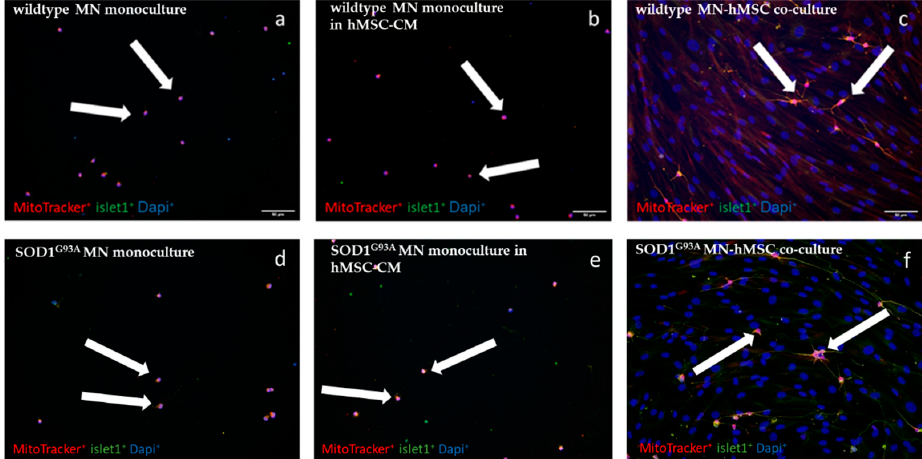
Figure 1. Increased MN number when co-cultured on hMSCs. Representative immunocytochemical stainings of MNs stained for Mitotracker (red), islet1 (green) and DAPI (blue). All images were recorded in a 20× magnification. ( a ) Wildtype MN monocultures. ( b ) Wildtype MNs cultured in hMSC-CM. ( c ) Wildtype MN-hMSC co-cultures. ( d ) SOD1 G93A MN monocultures. ( e ) SOD1 G93A MNs cultured in hMSC-CM. ( f ) SOD1 G93A MN-hMSC co-cultures. All arrows point towards Mitotracker and islet1 double positive MNs.